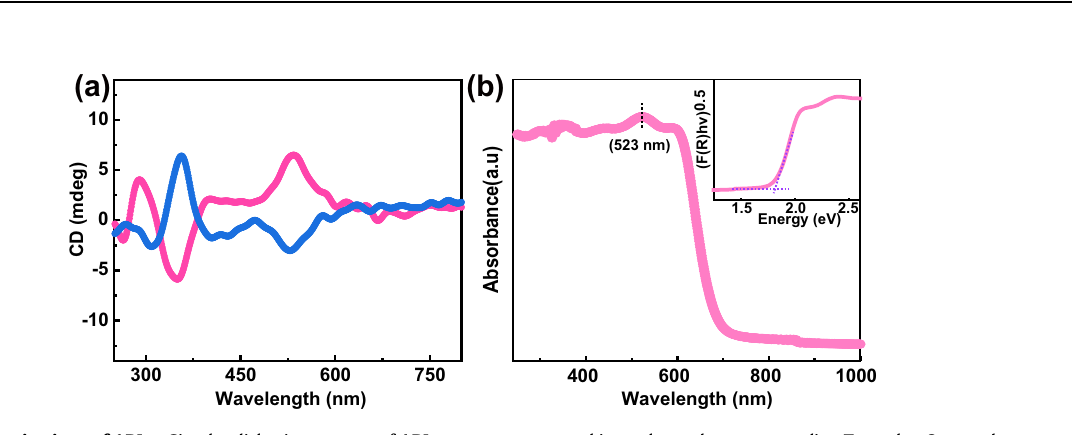
spectrum and inset shows the corresponding Tauc plot. Source data are provided as a Source Data fi